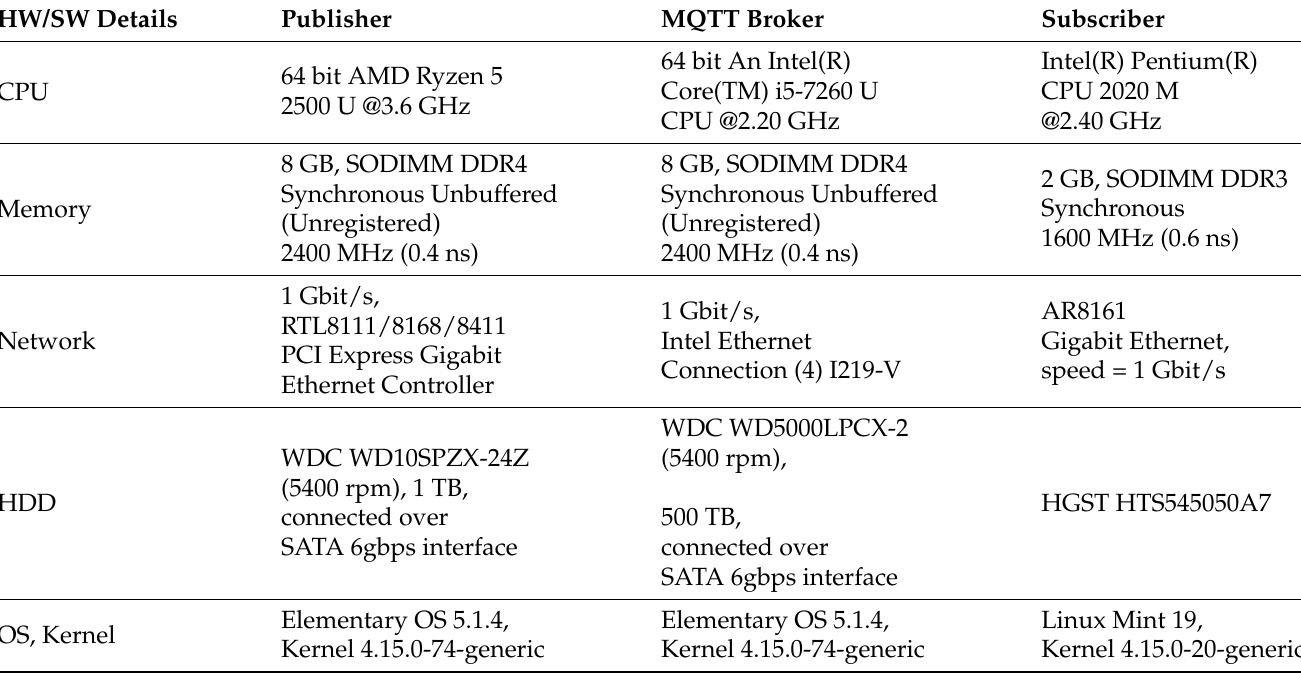
Table 2. Hardware and software details of the local testing environment.